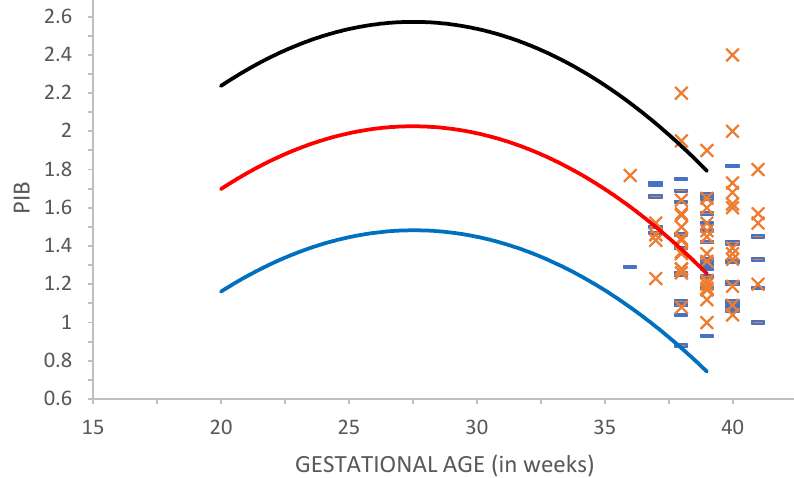
Figure 1. The values of Pulsatility index baseline in C1( - ) and C2 (x) compared to referent values in Tarzamni [27]. The blue line represents the 10th percentile, the red line represents 50th and the black line represents the 90th percentile.